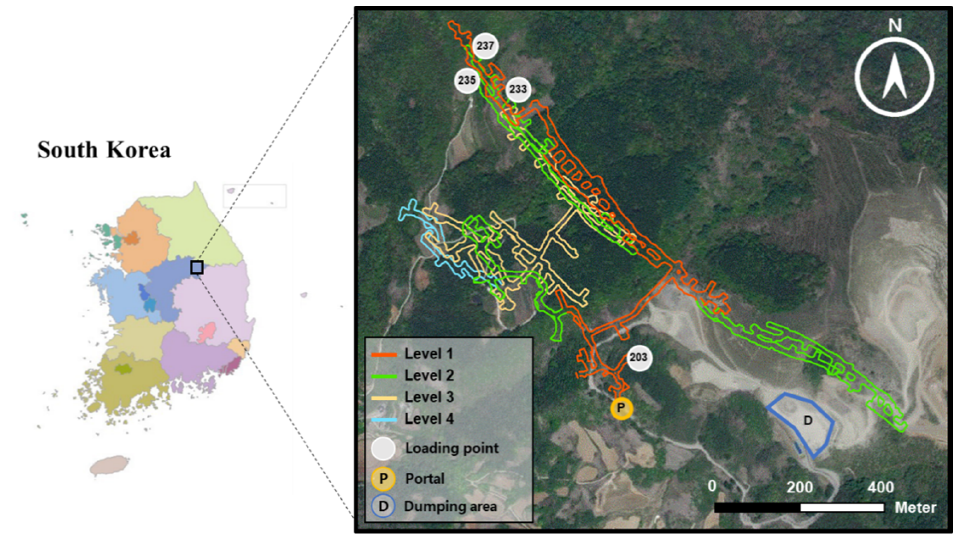
Figure 1. Aerial view of the study area displaying the various facilities. (Image source: National Geographic Information Institute of South Korea).